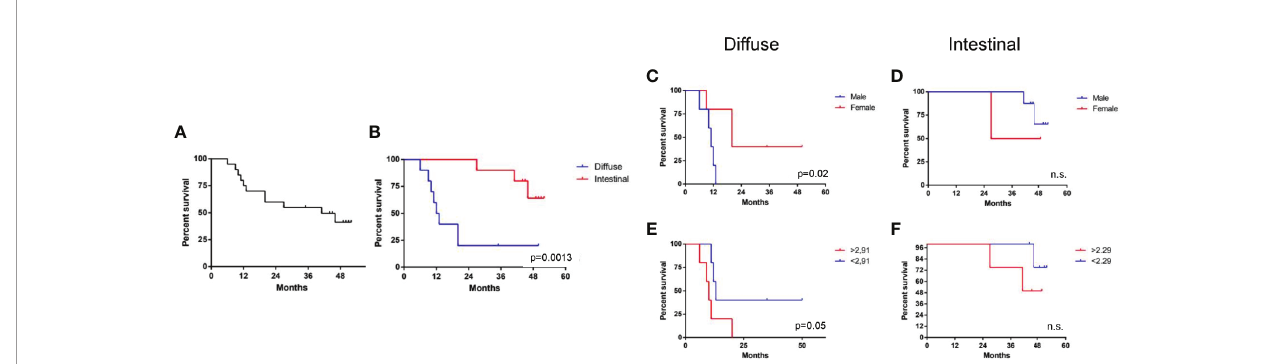
FIGURE 7 | Clinical results. (A) 4-year overall survival (4Y-OS) of the study population. (B) Kaplan – Meier survival curve showing the 4Y-OS of intestinal and diffuse group (p < 0.05). Analysis of 4Y-OS performed as described in material and method section according sex (C, D) or N/L ratio status (E, F) in diffuse and intestinal groups (p < 0.05).